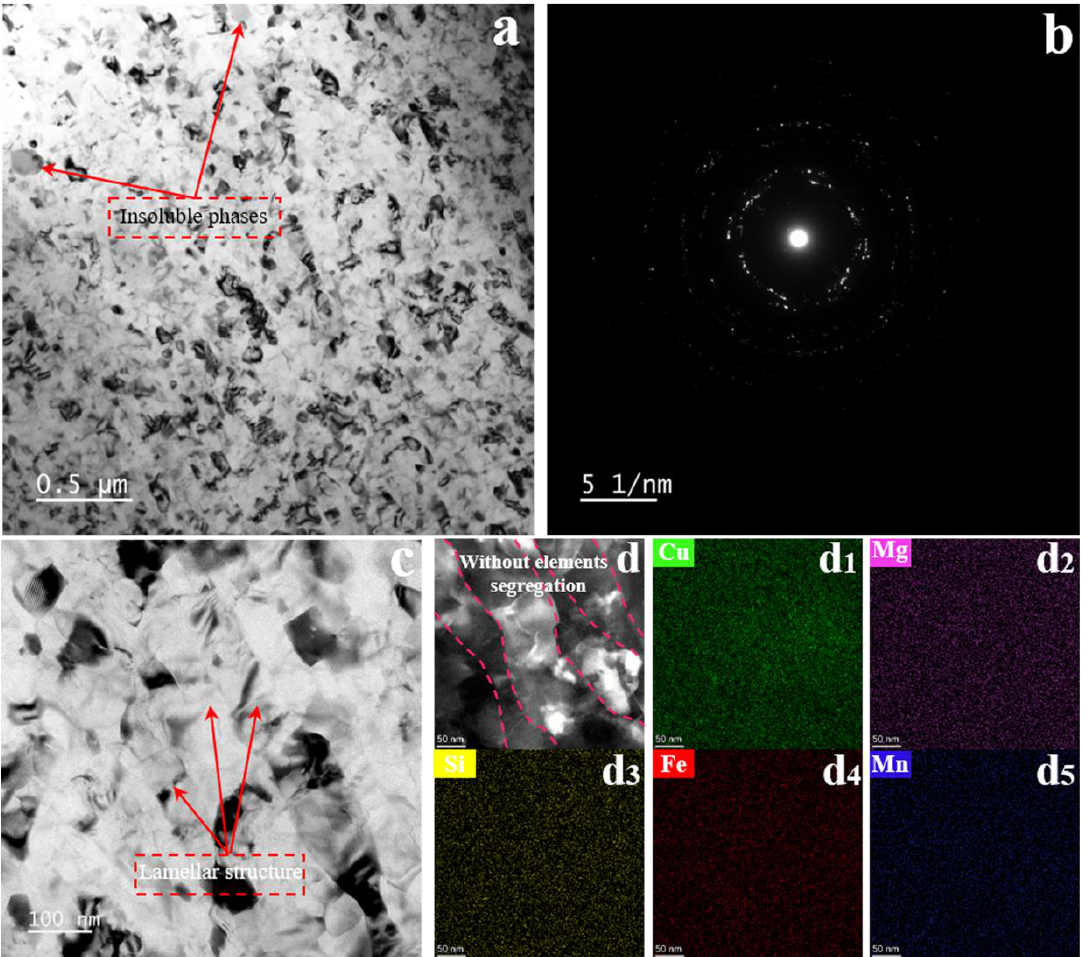
Figure 3. The solution treated with SMGT alloys. Low-magnification bright-field TEM image ( a ) and the corresponding selected area diffraction pattern ( b ), high-magnification bright-field TEM image ( c ), HAADF-STEM image ( d ), and the corresponding EDS elemental maps of copper ( d 1 ), magnesium ( d 2 ), silicon ( d 3 ), iron ( d 4 ), and manganese ( d 5 ).